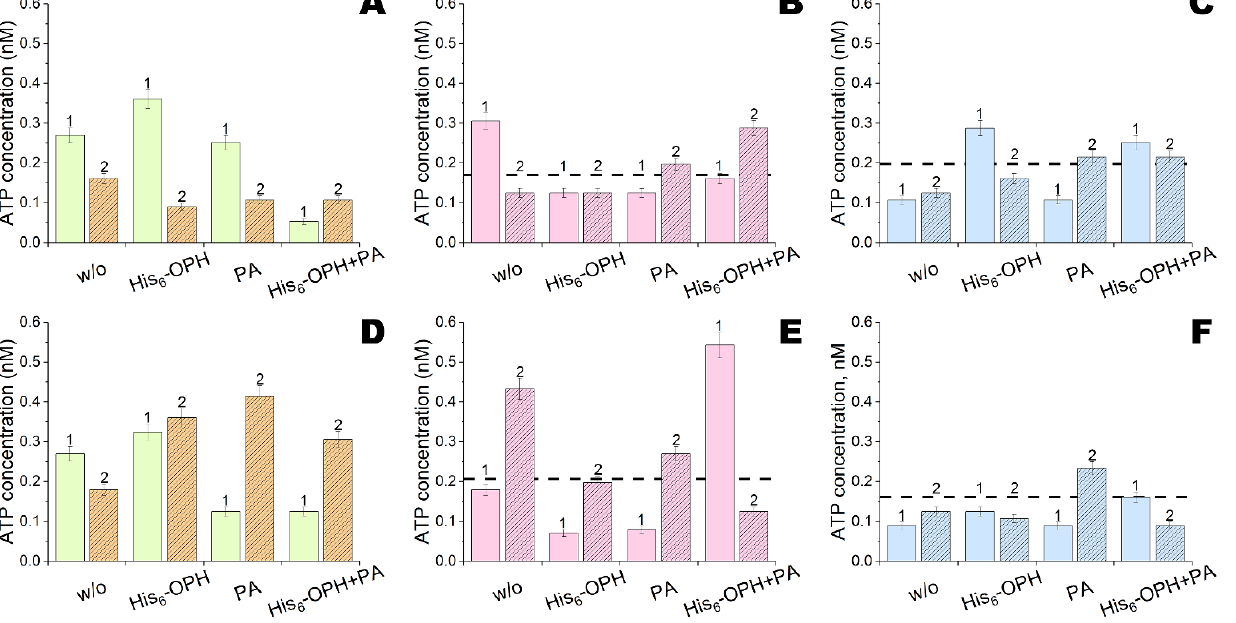
Figure 7. Antibacterial activity of emodin (#1) and naringenin (#2) NCs with His 6 -OPH and/or penicillin acylase (PA) towards B.subtilis ( A – C ) and E.coli ( D – F ) cells without any additional antibiotics ( A , D ) and with addition of colistin ( B , E ) or polymyxin B ( C , F ). The levels of ATP with these antibiotics alone are labeled with dashed lines. Emodin and naringenin were applied at a dose of 1 and 10 ng per sample, respectively.